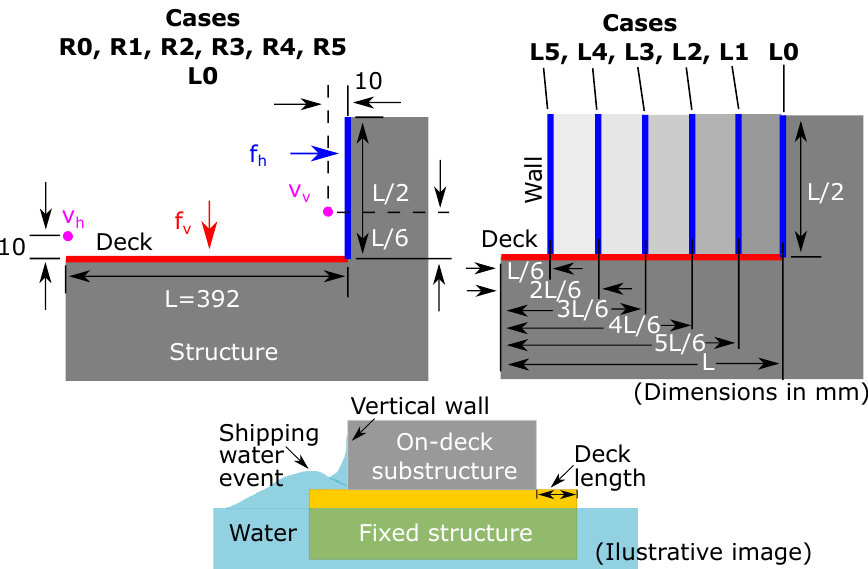
Figure 7. Sketch of the configuration of the study cases analysed